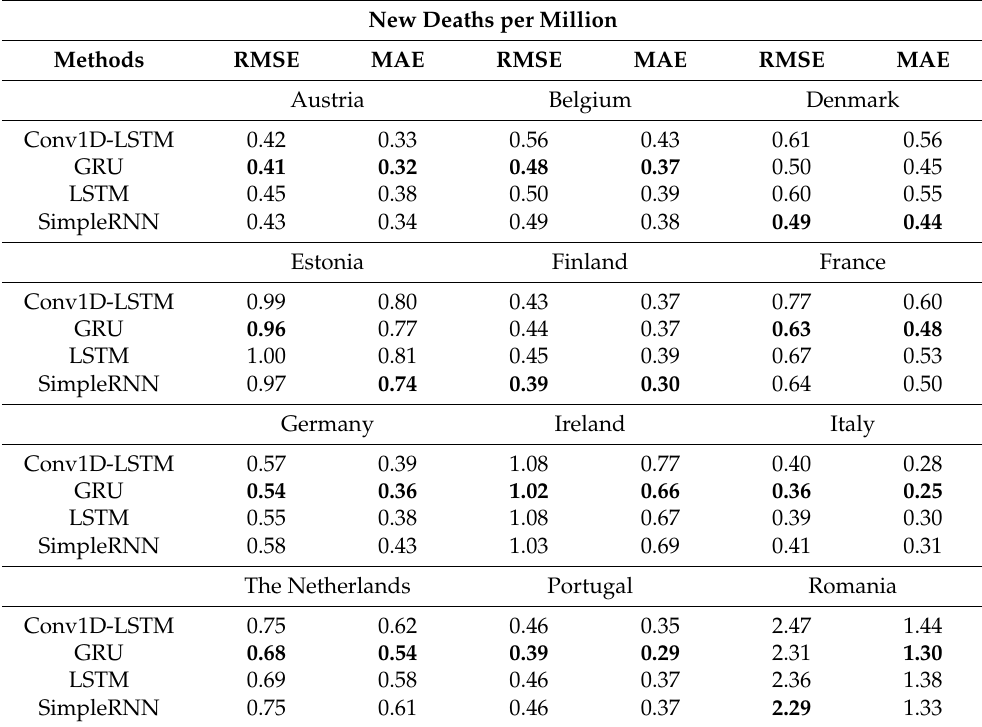
Table 4. Errors for the daily deaths per million for each country per method. The minimum MAE and RMSE errors per country are in